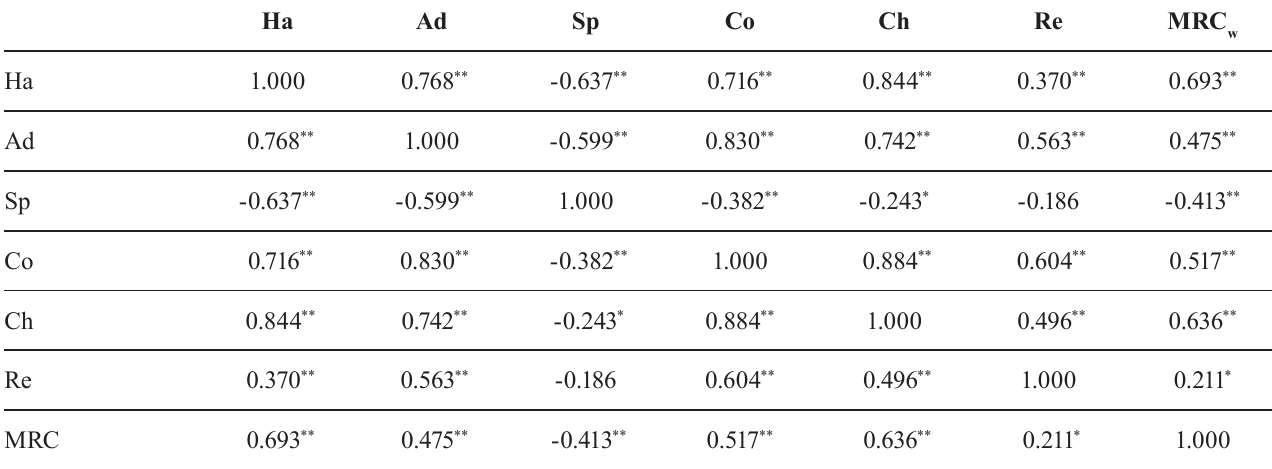
and the six physical properties of wet w